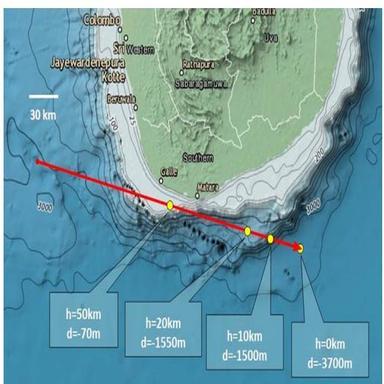
The WT1190F entry trajectory superposed to the bathimetric map of Sri Lanka offshore, according to National Centers of Environmental Information of the NOAA (USA). Labelled on the plot are the ballistic reference altitude (in kilometers) and the underlying sea depth (in meters) at some reference points along the trajectory. See text for full discussion.